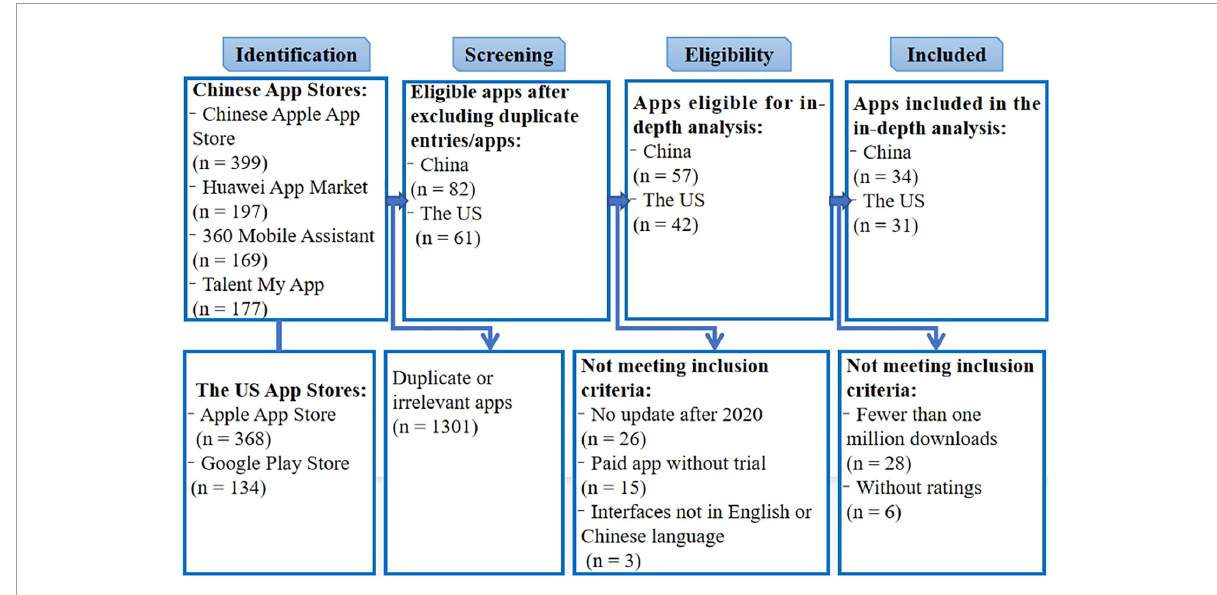
FIGURE1 Flowchart of the selection process for apps included in the review.